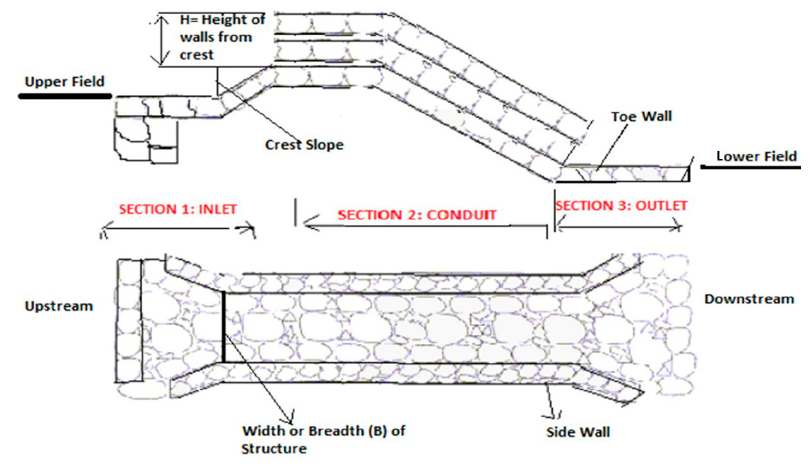
Figure 3. Cross-section of a loose stone structure.